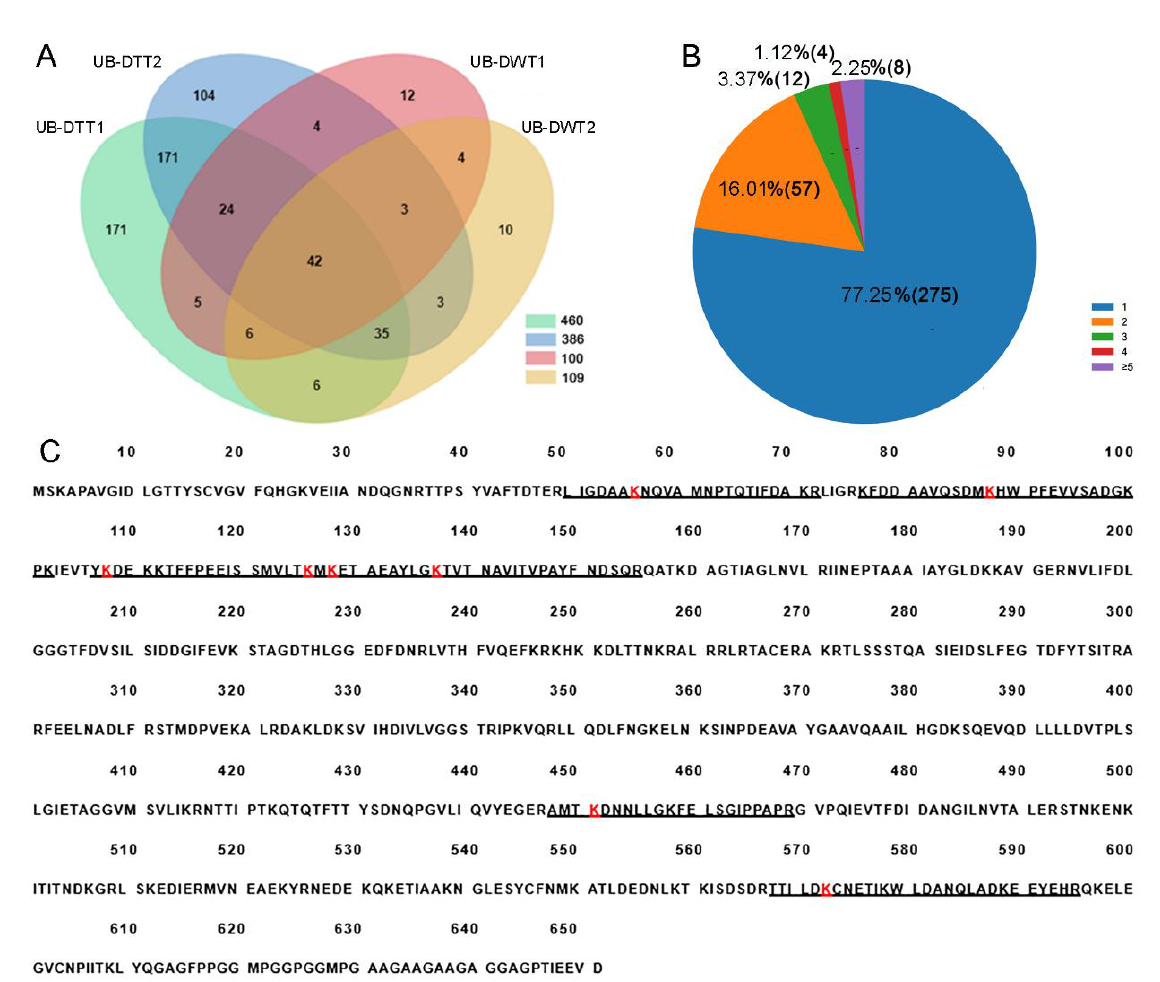
Figure 3. Identification of lysine ubiquitination sites in DTT and DWT. ( A ) Venn diagram showing overlaps of proteins in UB-DTT and UB-DWT. ( B ) Distribution of the number of lysine ubiquitination sites in the identified ubiquitinated peptides. ( C ) Eight lysine ubiquitination sites (red K) present in HSC70-4 protein. The underline sequences indicate the detected peptides. The red “K” is the lysine ubiquitination site.